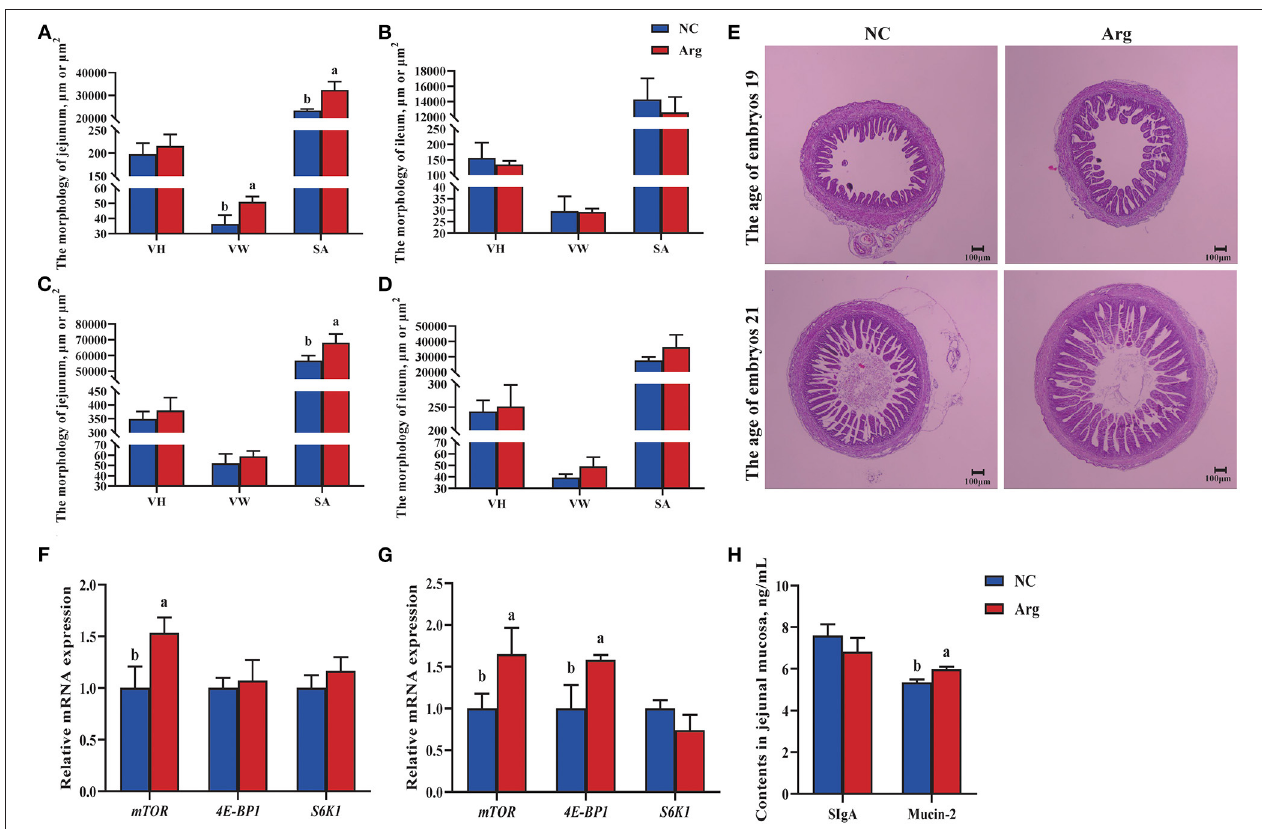
FIGURE 1 | Effects of in ovo feeding of L -arginineon the development of embryonic intestine of chicks. a − b Values at the same index with no common superscripts differ significantly ( p < 0.05). (A,B) The intestinal morphology of jejunum and ileum at the age of embryos 19 (19 E), respectively; (C,D) The intestinal morphology jejunum and ileum at the age of embryos 21 (21 E), respectively; (E) Intestinal morphological structure of jejunum at 19 and 21 E, respectively. The pictures were observed at 40 × magnification; (F,G) , the relative mRNA expression of genes in the mTOR pathway of jejunum at 19 E and 21 E, respectively; (H) , the contents of SIgA and Mucin-2 of jejunum at 21 E; NC, non-injected control group; Arg, in ovo of feeding of 7mg L -arginine group; VH, villus height; VW, villus width; SA, surface area of villus, which was calculated according to the formula 2 π × VH × (VW/2); SIgA, Secretory Immunoglobulin